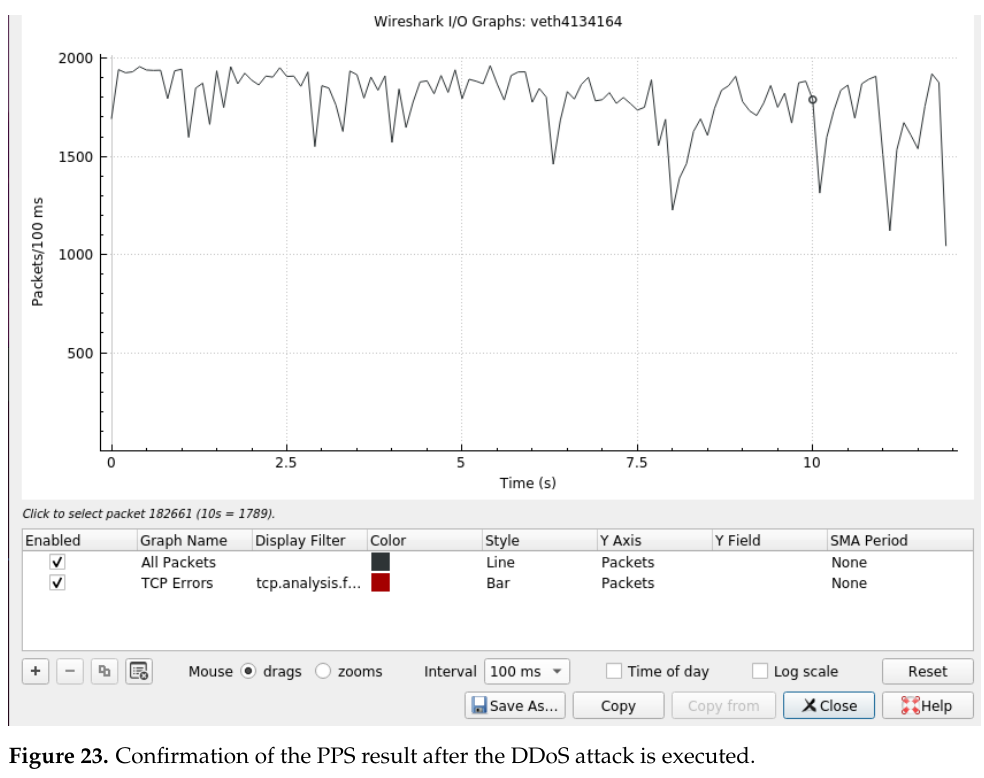
Figure 23. Confirmation of the PPS result after the DDoS attack is executed.